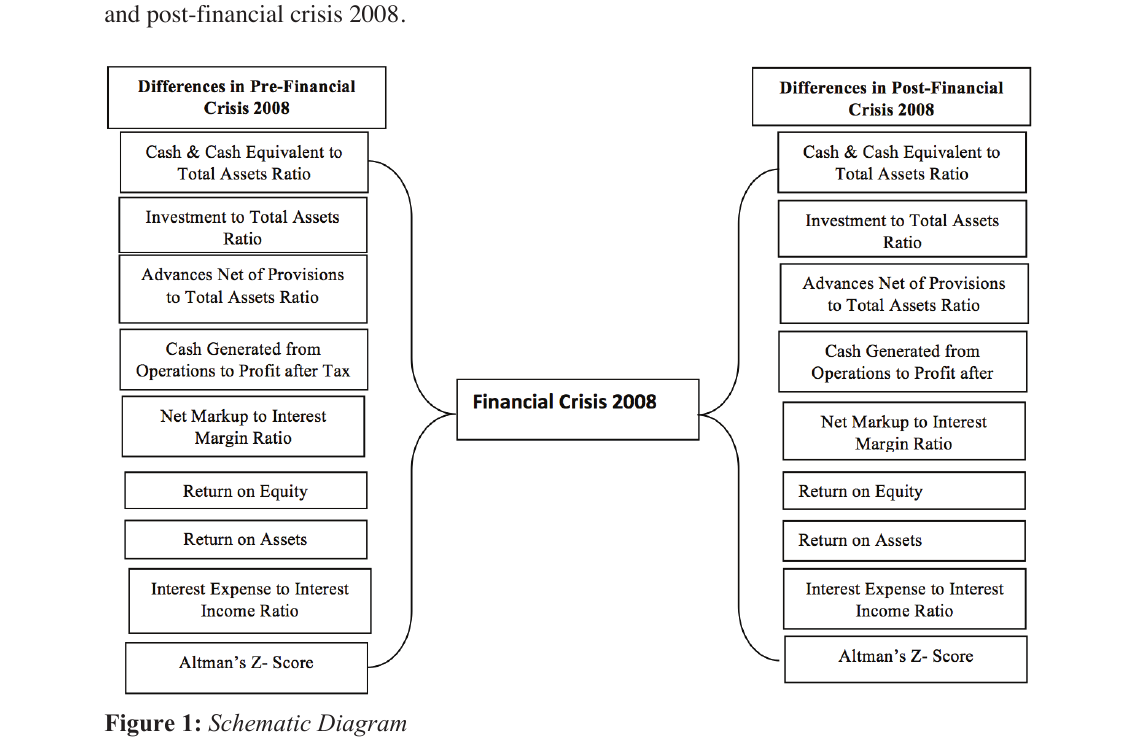
Figure 1: Schematic